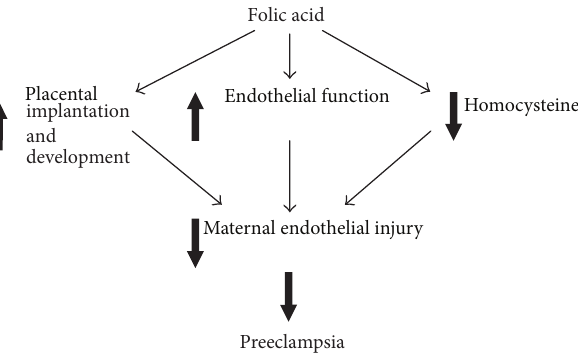
Figure 1: Schematic of different proposed mechanisms of action by which folic acid decreases the risk of developing